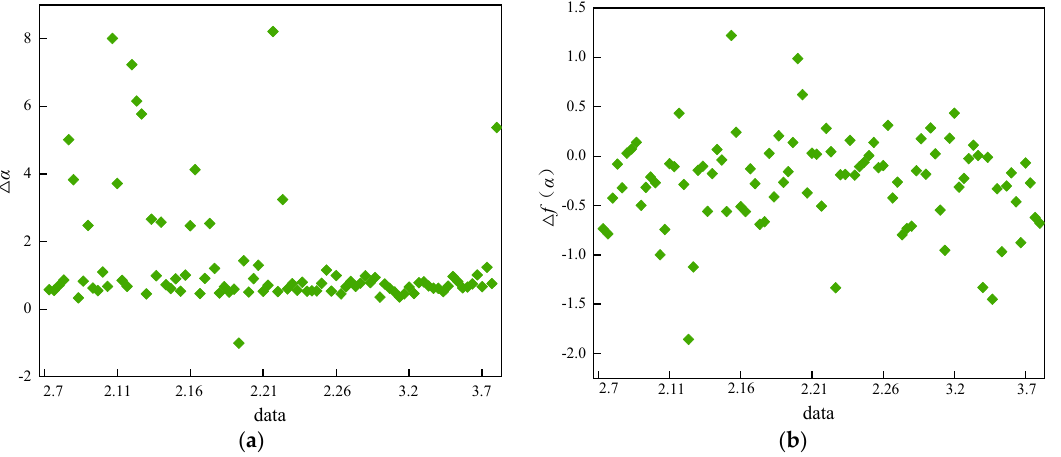
Figure 13. Time varying response law of multifractal characteristic quantity: ( a ) parameter ∆ α , ( b ) parameter ∆ f ( α